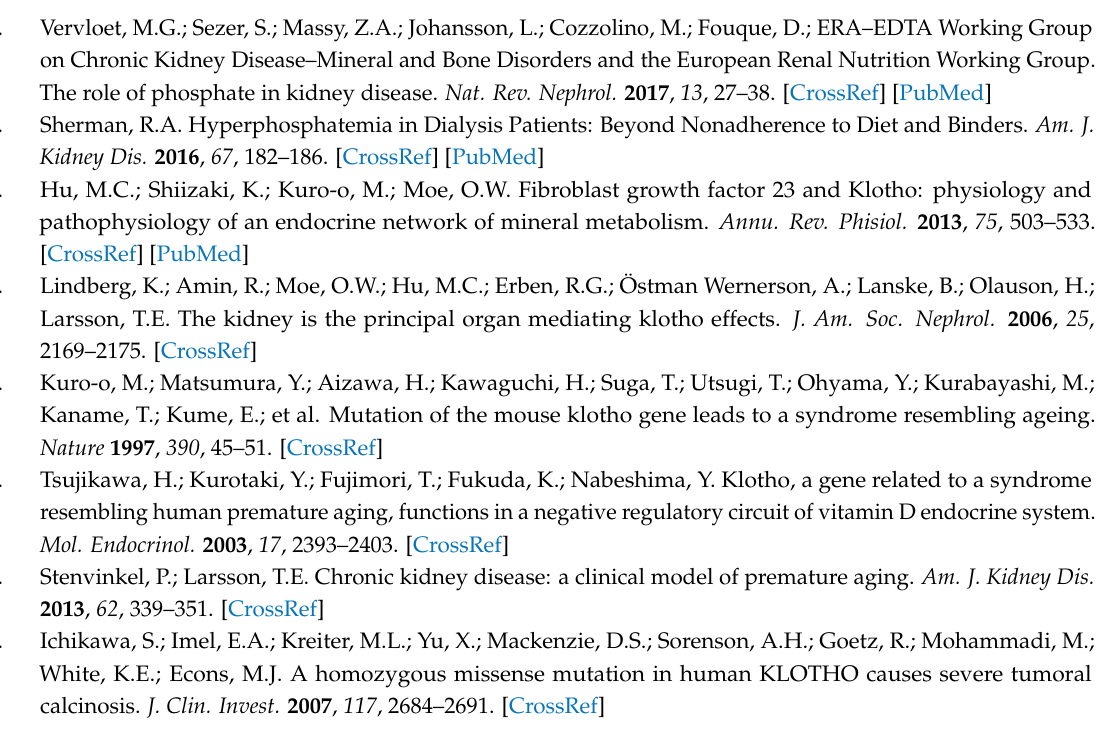
s1; Table S1: Data of the two groups of hemodialysis patients with normal and elevated serum phosphate; File S1: Sequence data files of KL gene variant identified. (A) KL gene exon 2 and (B) KL cDNA; File S2: